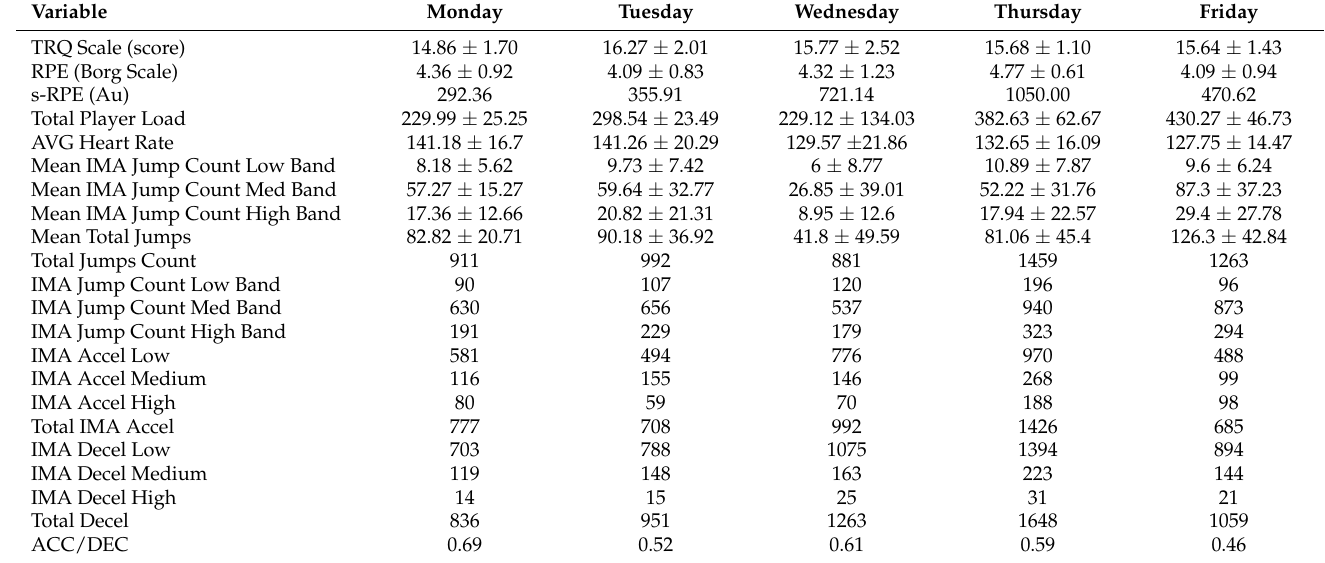
Table 3. Player Load Markers measured during a five-day training